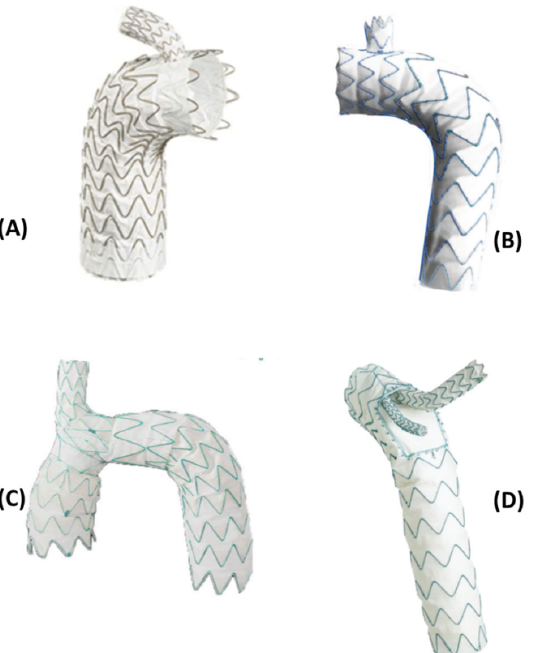
Figure 3. Endografts included in this review, covering a range of deployment zones and configurations. ( A ) Gore TAG endograft, ( B ) Castor Aortic Branched Stent-Graft (both single-branched, Zone 2 deployment), ( C ) Nexus TM endograft (Single-branched, Zone 0 deployment), ( D ) RelayPlus endograft (Double ‐ branched with inner tunnel branches, Zone 0 deployment) [2,34,38].